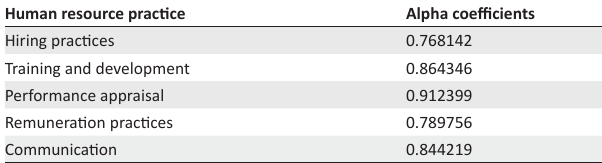
TABLE 8: Alpha coefficients of the Human Resource Practices